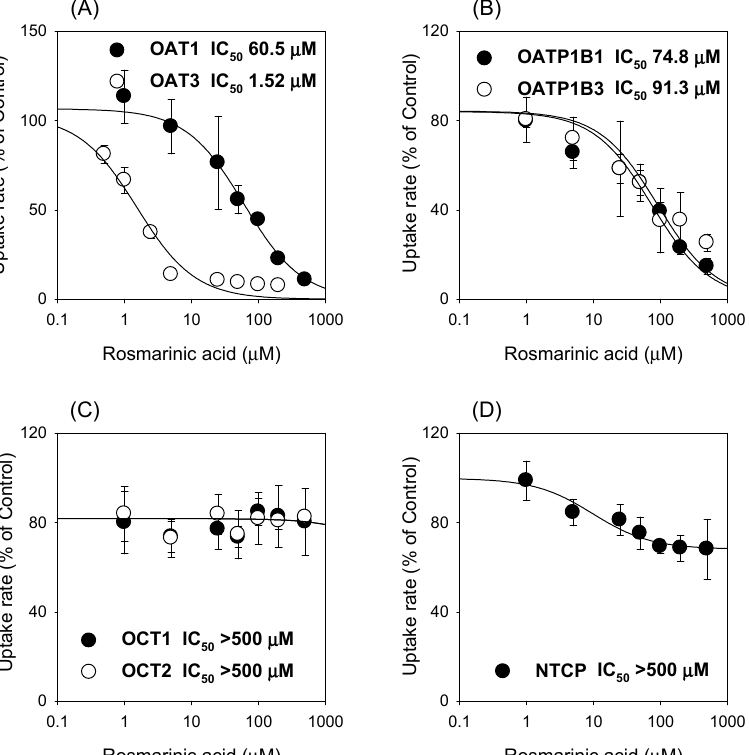
Figure 5. ( A ) The inhibitory effect of rosmarinic acid (1–500 µ M) on the OAT1- and OAT3-mediated uptake of 0.1 µ M [ 3 H]para-aminohippuric acid and 0.1 µ M [ 3 H]estrone-3-sulfate, a probe substrate for OAT1- and OAT3, respectively. ( B ) The inhibitory effect of rosmarinic acid (1–500 µ M) on the OATP1B1- and OATP1B3-mediated uptake of 0.1 µ M [ 3 H]estrone-3-sulfate and 0.1 µ M [ 3 H]estradiol-17 β -D-glucuronide, a probe substrate for OATP1B1 and OATP1B3, respectively. ( C ) The inhibitory effect of rosmarinic acid (1–500 µ M) on the OCT1- and OCT2-mediated uptake of 0.1 µ M [ 3 H]methyl-4-phenylpyridinium, a probe substrate for OCT1 and OCT2. ( D ) The inhibitory effect of rosmarinic acid (1–500 µ M) on the NTCP-mediated uptake of 0.1 µ M [ 3 H]taurocholate, a probe substrate for NTCP. Each data point represents the mean ± standard deviation ( n = 3).